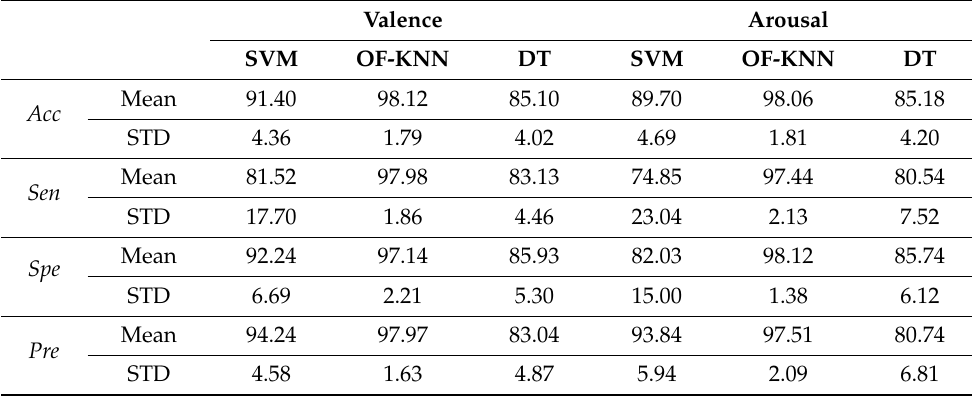
Table 6. Performance estimation for combined features